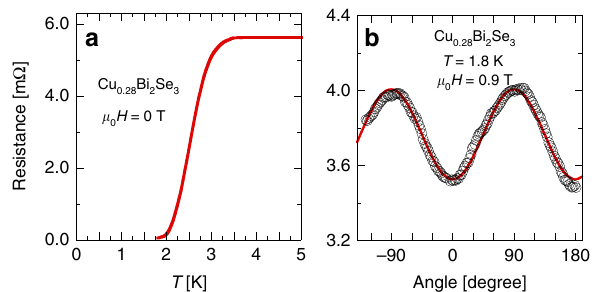
Fig. 4 In-plane upper critical fi eld anisotropy determined by magnetic susceptibility. a Magnetic fi eld dependence of the ac- χ at different in-plane angle ϕ for the sample with x = 0.28. The solid curves are guides to the eyes. The arrows indicate H c2 for each angle, which is de fi ned as a point off the straight line drawn from high- fi eld value (the normal state). The error was estimated by assuming that the uncertainty equals twice point-interval in measuring the ac- χ vs fi eld curve. For more details see Supplementary Information. The inset is an illustration depicting the hexagonal plane and the angle ϕ . b H c2 plotted as a function of in-plane angle ϕ . The blue curve is a sine